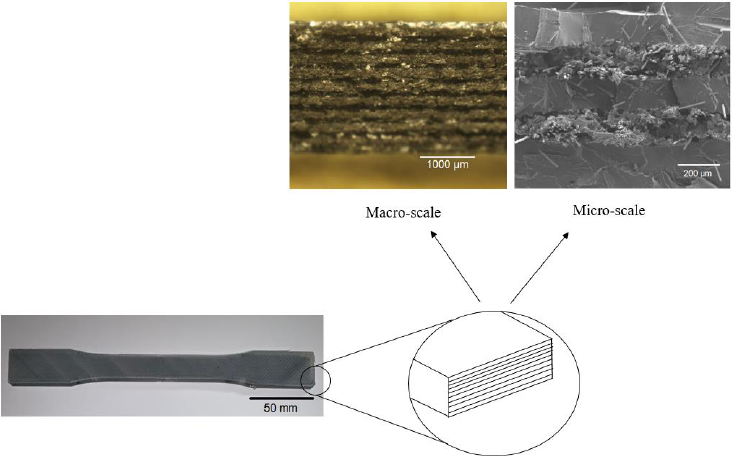
Figure 1. Schematic representation of a CFRAM component and different layers in macro and micro scales.